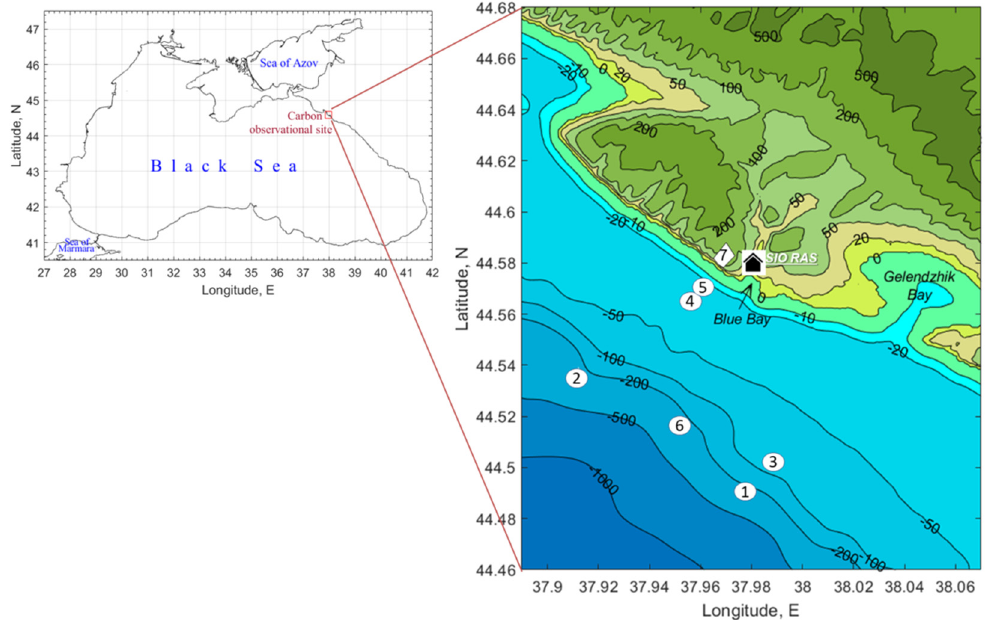
Figure 1. Left —The Black Sea coastline and location of the carbon observational site. Right —Bathymetry of the Northeastern Black Sea area near the carbon observational site. Bathymetry is based on the ETOPO1 Global Relief Model (shading (m)); (https://www.ngdc.noaa.gov/mgg/global/, last access: 24 September 2021). Numbers in the circles indicate observation instruments deployed or planned for deployment as follows: (1)—moored automatic mobile profiler for monitoring of the dissolved oxygen; (2)—moored automatic mobile profiler for environmental monitoring; (3)—mooring buoy for the monitoring of GNGs; (4)—shallow-water tethered profiler Winchi (presented in this study) to observe the environment; (5)—bottom mounted wave and current meter connected by an optical cable to the coast; (6)—subsurface mooring for suspended matter and carbon flux monitoring; and (7)—the terrestrial part of the observational site to observe the GHGs, carbon flux, wind, and weather.